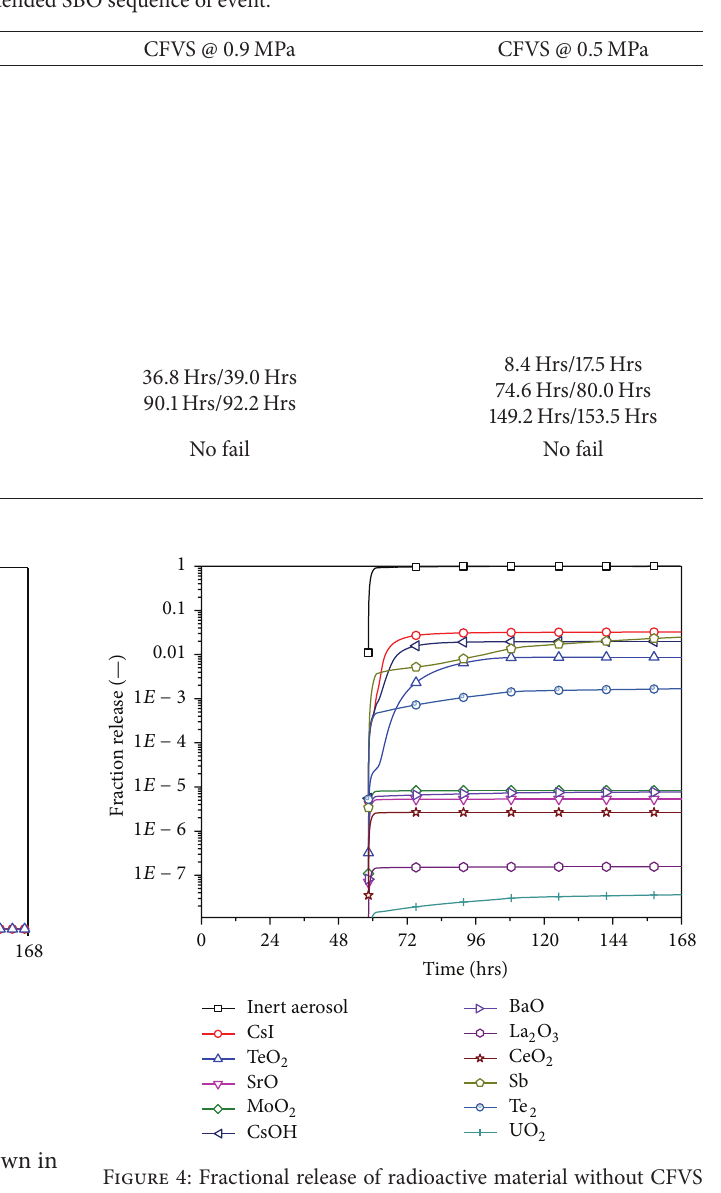
Table 3: Extended SBO sequence of event.